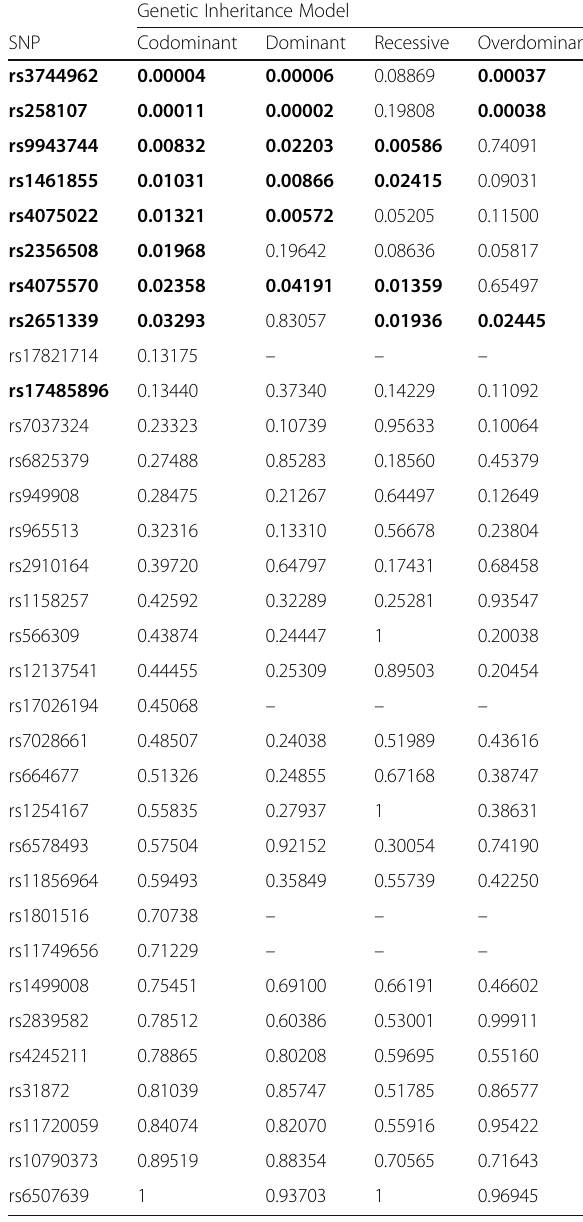
Table 3 Association analysis of thyroid carcinoma and SNPs under different genetic inheritance model. The SNPs rs258107 and rs3744962 remained significant after the correction of multiple Bonferroni test. P < 0.05 in bold. Dominant, AA/Ab + bb; Recessive, AA + Ab/bb; Overdominant, Ab/AA + bb; e